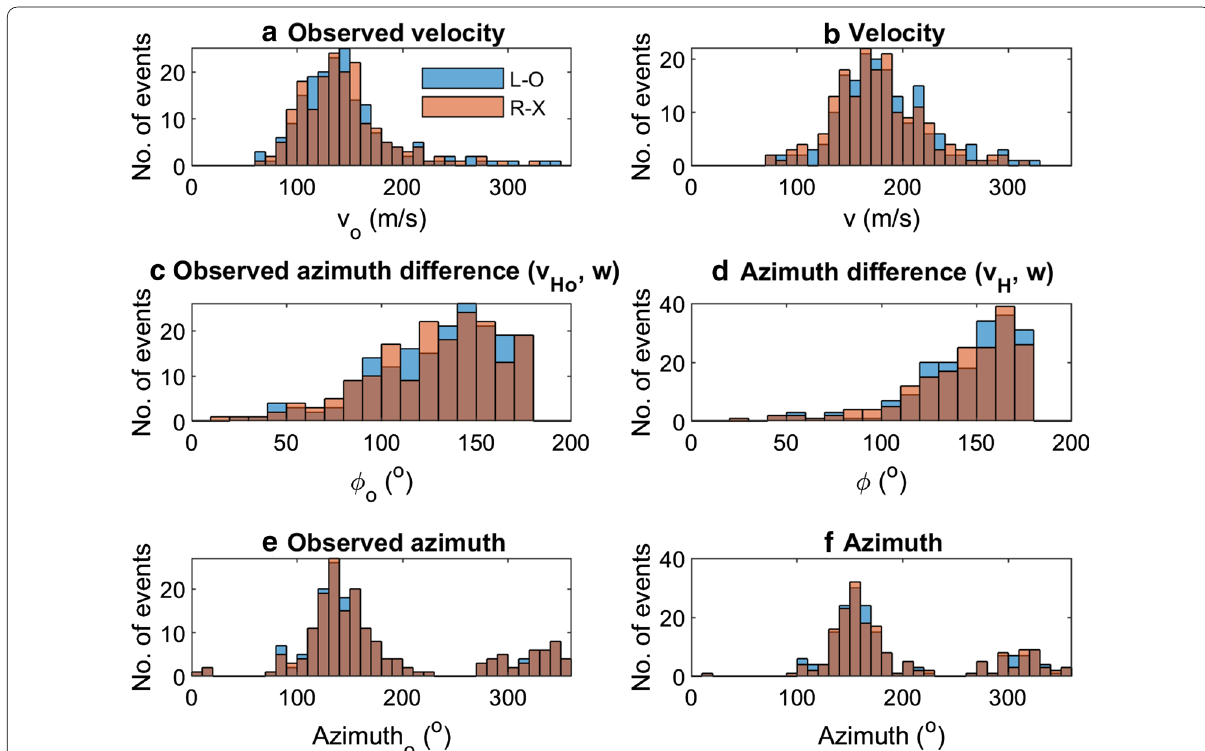
Fig. 2 Distribution of selected GW characteristics for the period July 2014–June 2015 (solar maximum) assuming L-O mode (blue) and R-X mode (orange) signals. a observed velocities v o , b wind rest frame velocities v , c observed azimuth difference φ o between v o ( v Ho ) and horizontal velocity w of neutral winds, d azimuth difference φ between v ( v H ) and horizontal velocity w of neutral winds, e observed azimuth, f